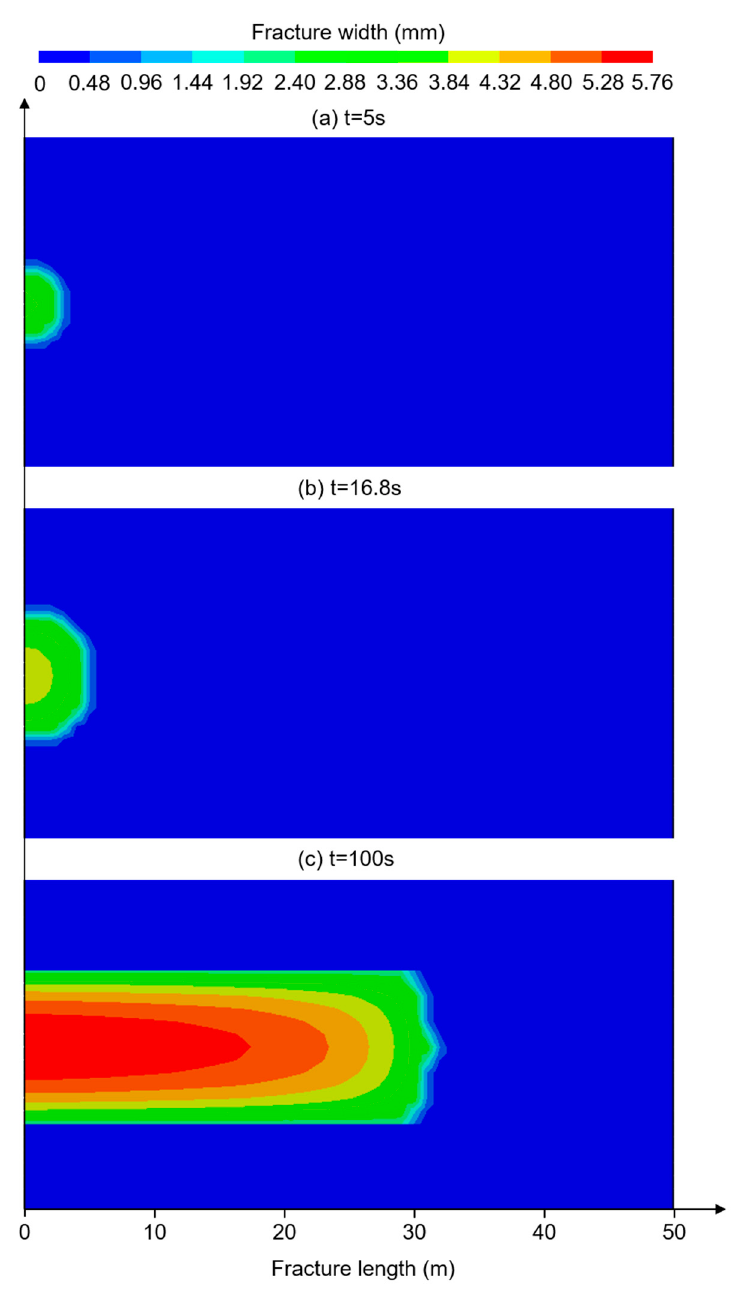
Figure 6. Fracture width at different times. ( a ) t = 5 s, ( b ) t = 16.8 s and ( c ) t = 100 s.